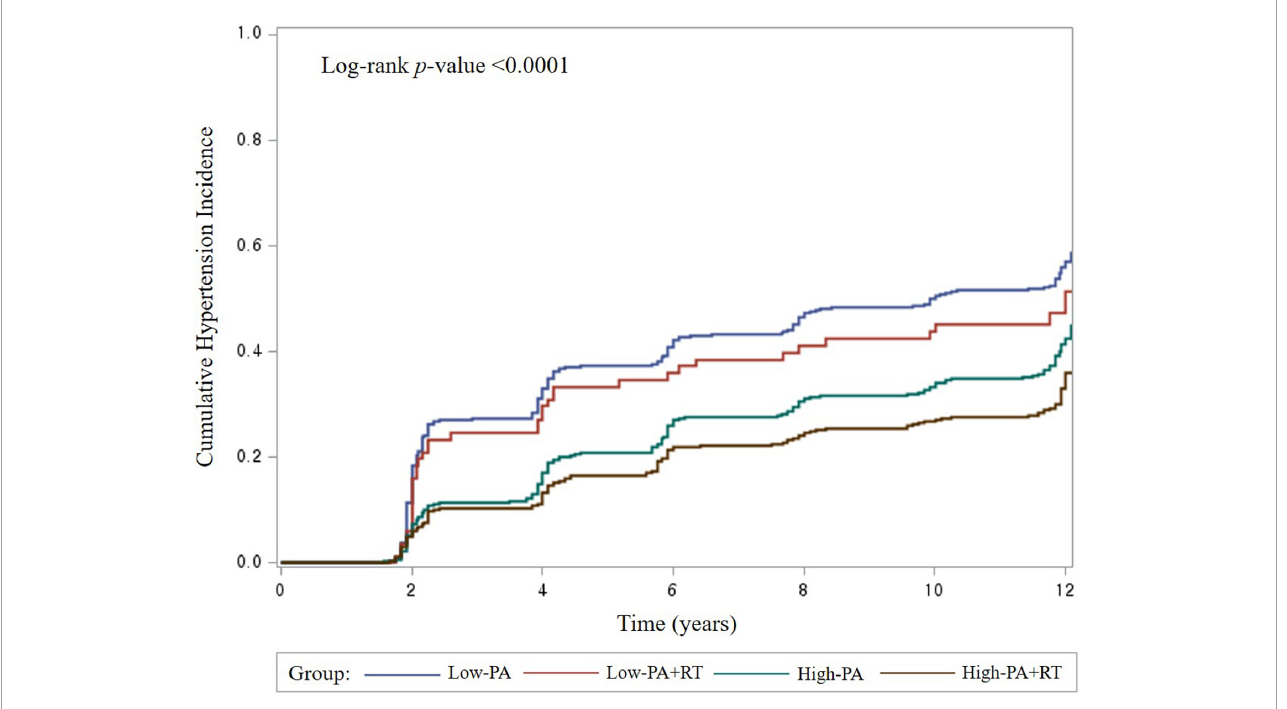
FIGURE2 Cumulative incidence of hypertension in the four